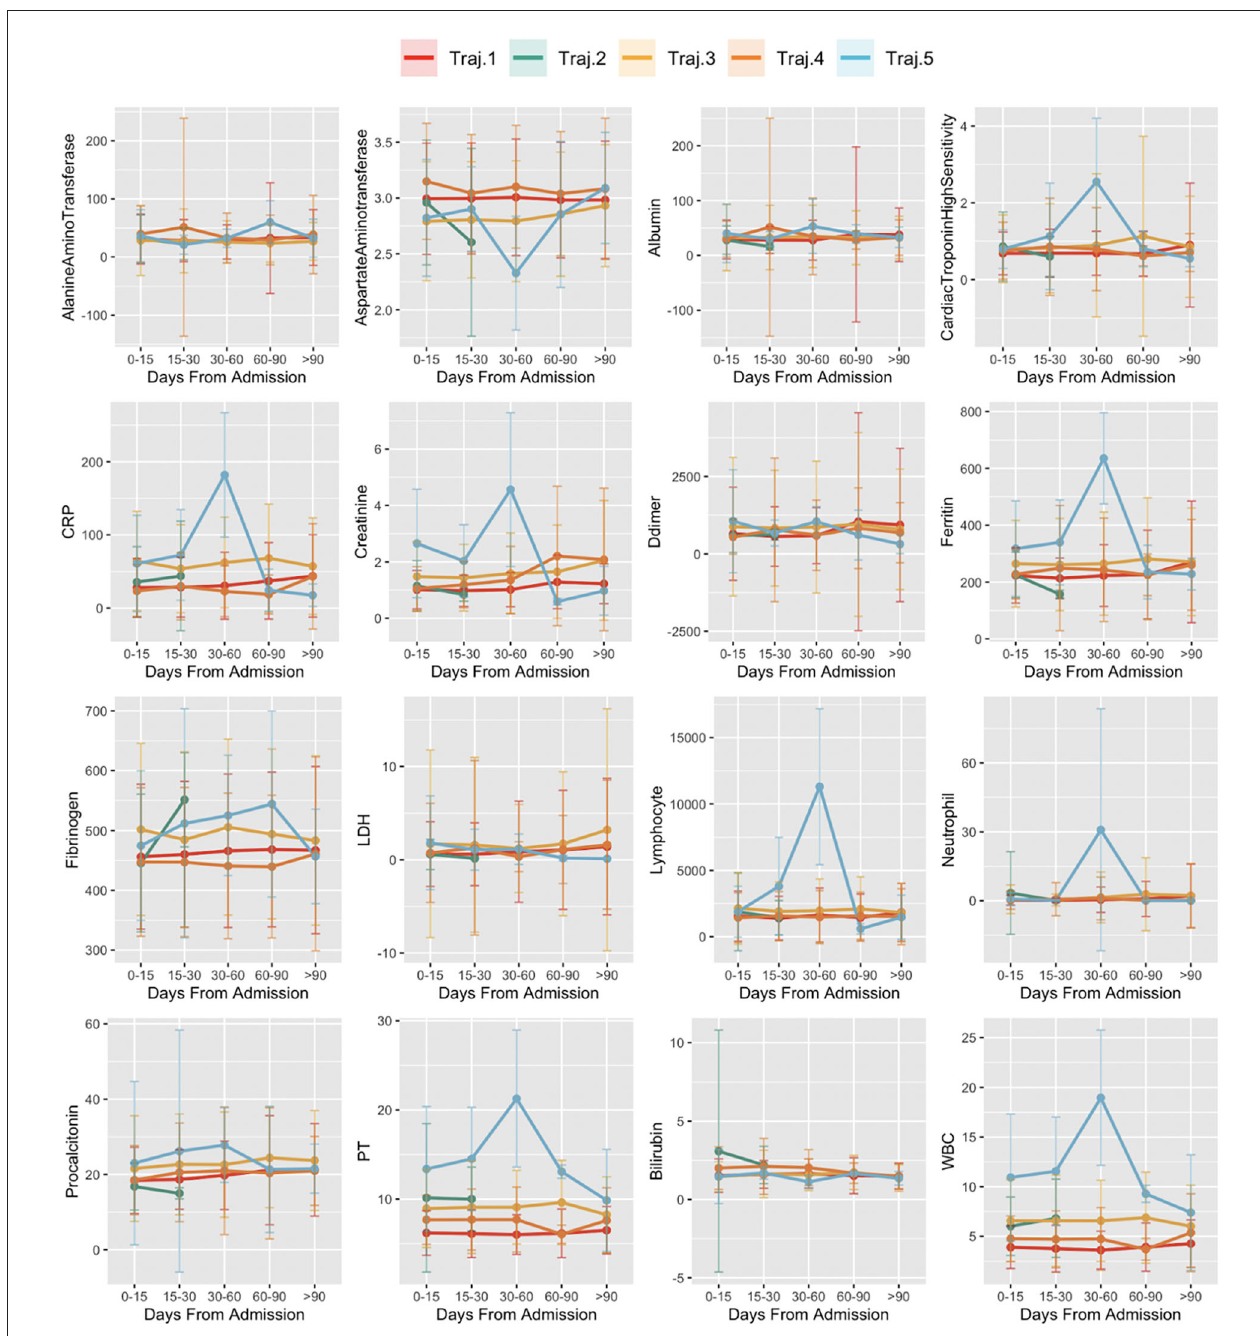
FIGURE 8 | Laboratory values in time in trajectories. The x-axis indicates the disease stages time windows, from the first positive PCR test. Values of the y-axis indicate the average value of the laboratory test results in the time window and its standard error.